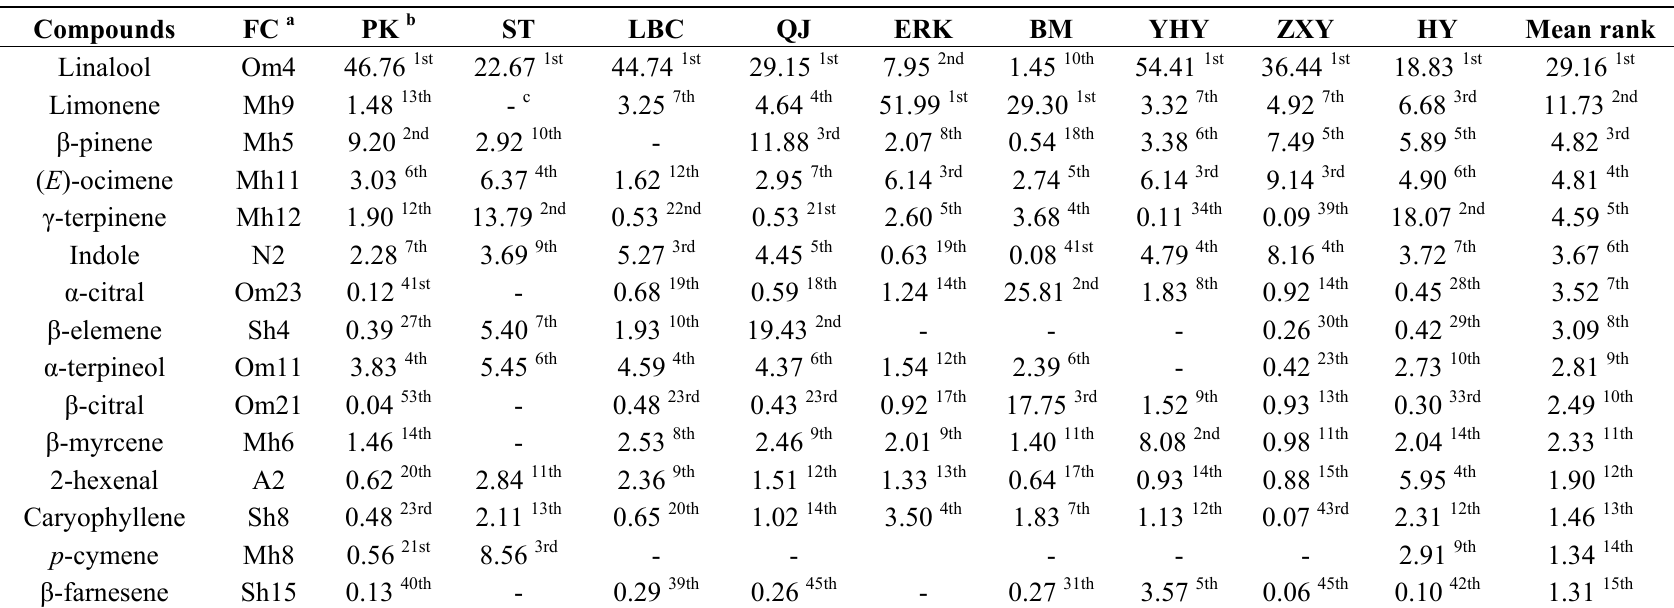
Table 3. Major volatiles compounds, in percentages and rank, from unopened flowers from nine citrus cultivars. Compounds Linalool